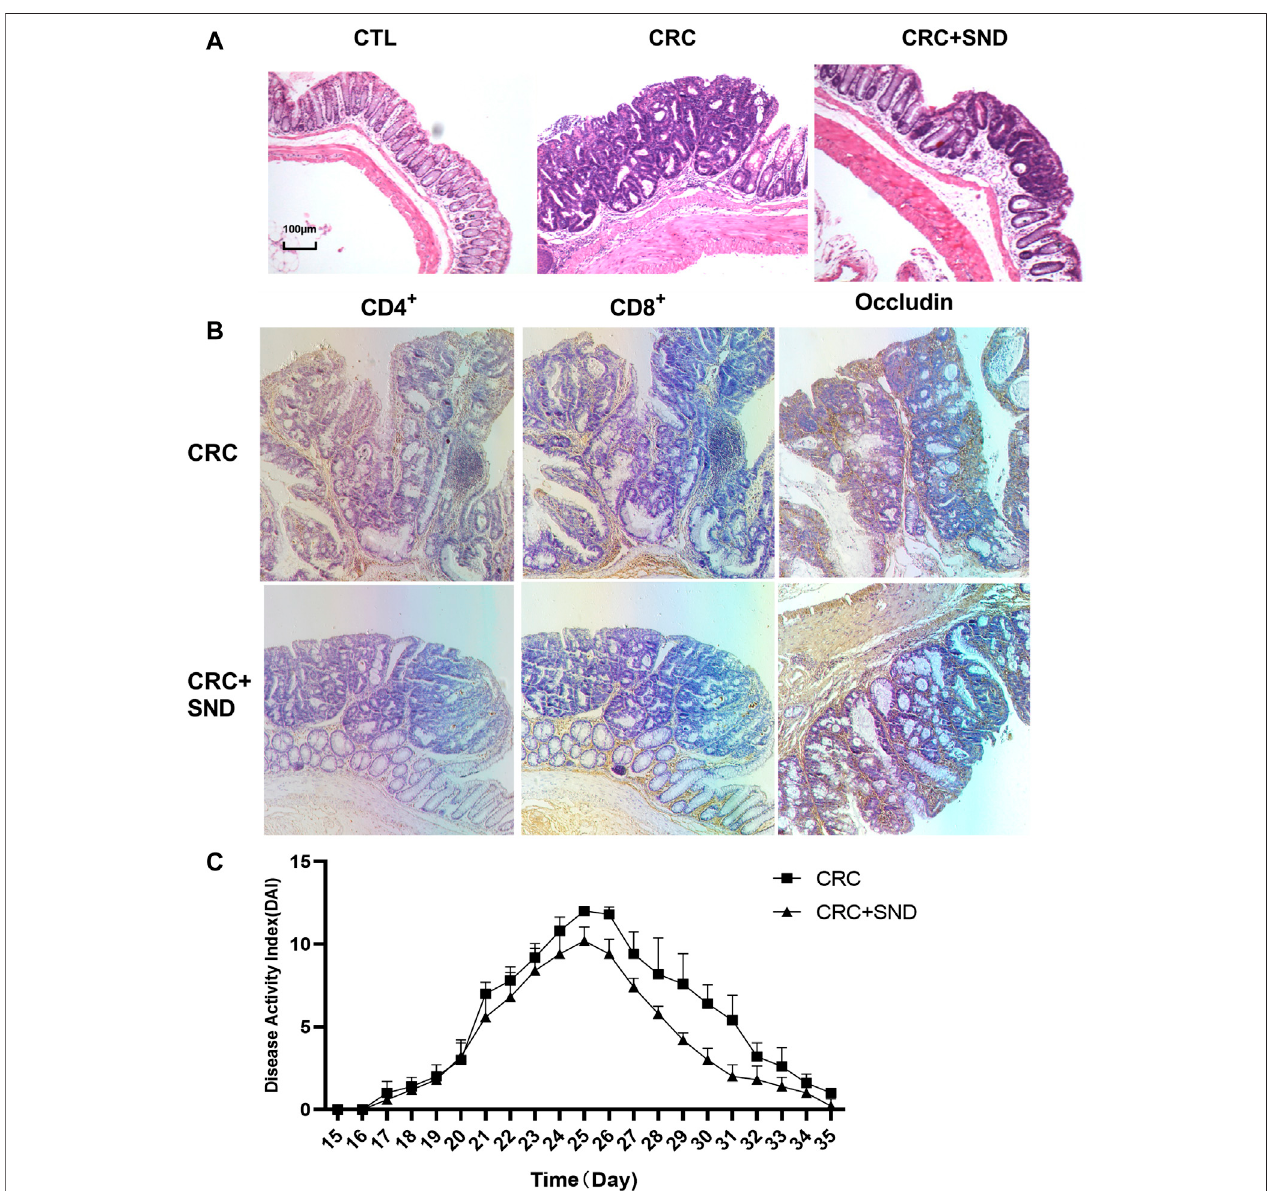
FIGURE 3 | Pathological and immunohistochemical analysis. (A) The pathological phenotype of different groups. SND can Reduce the degree of tumor malignancy. (B) Immunohistochemical results of CD4 + , CD8 + T cells, and Occludin quantity in CRC and CRC + SND group. (C) The disease Activity Index (DAI) of CRC and CRC + SND groups in the acute enteritis phase